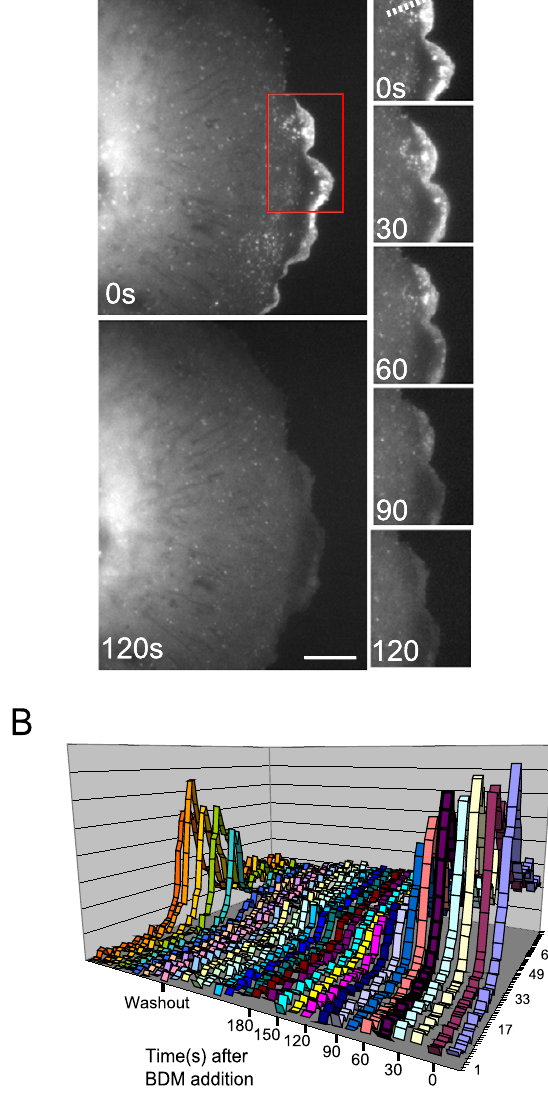
Figure 5 Arp3 de-localization consistent with dissociation from the actin network. (A) Time-lapse sequence of a BS- C-1 cell expressing Arp3-GFP shows delocalization of Arp3 within 2 minutes of BDM addition. (B) A linescan of the area marked at 0s (dotted line) plotted over time shows gradual loss of fluorescence with only slight retraction of the leading edge. Washout brings a return of fluorescence in ~1 minute. Bar, 10